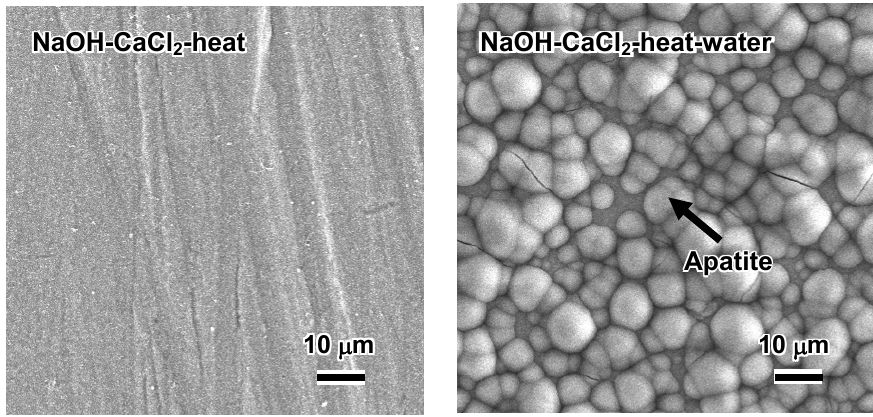
Figure 16. SEM photographs of the surfaces of Ti-15Zr-4Nb-4Ta alloy soaked in SBF for and heat treatments, and subsequent water 3 d after NaOH, CaCl 2